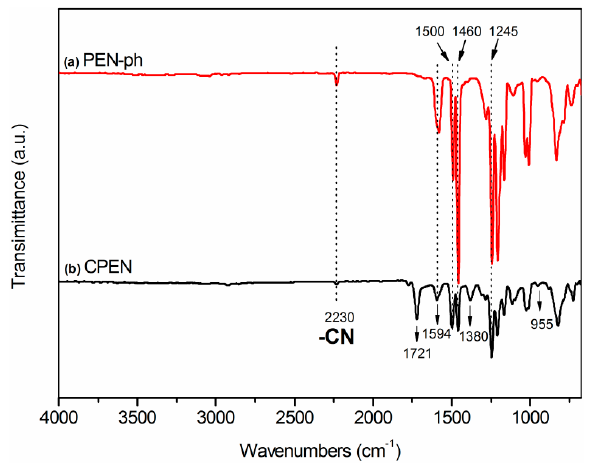
Figure 5. FTIR spectra of: ( a ) PEN-ph; and ( b ) CPEN films.